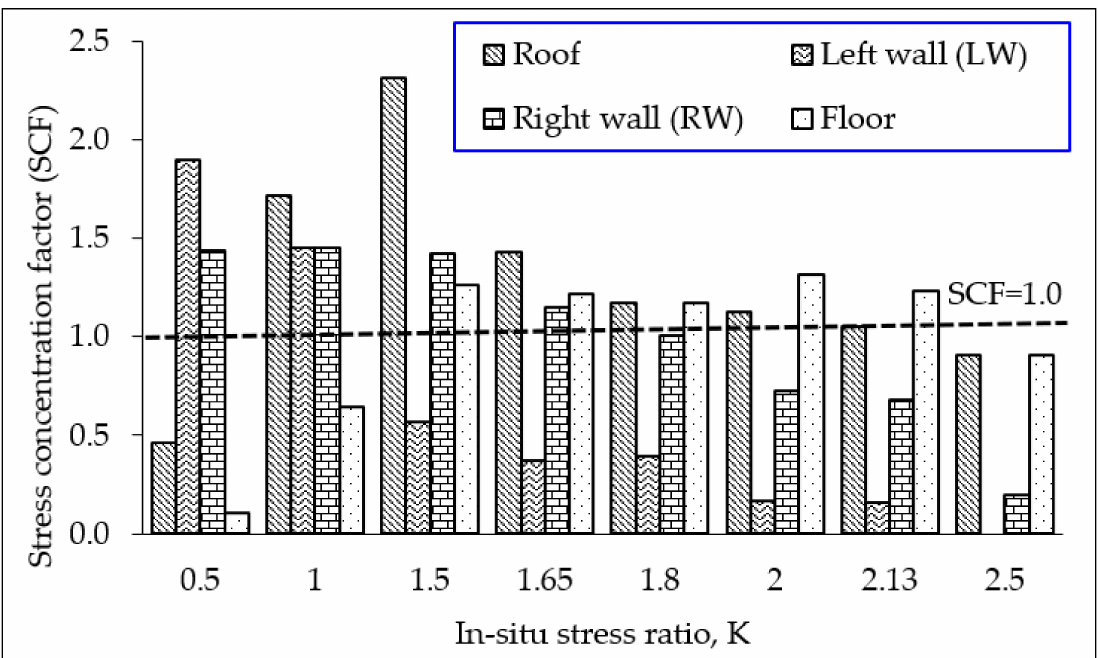
Figure 9. Stress concentration around tunnel opening at different states of in situ stress